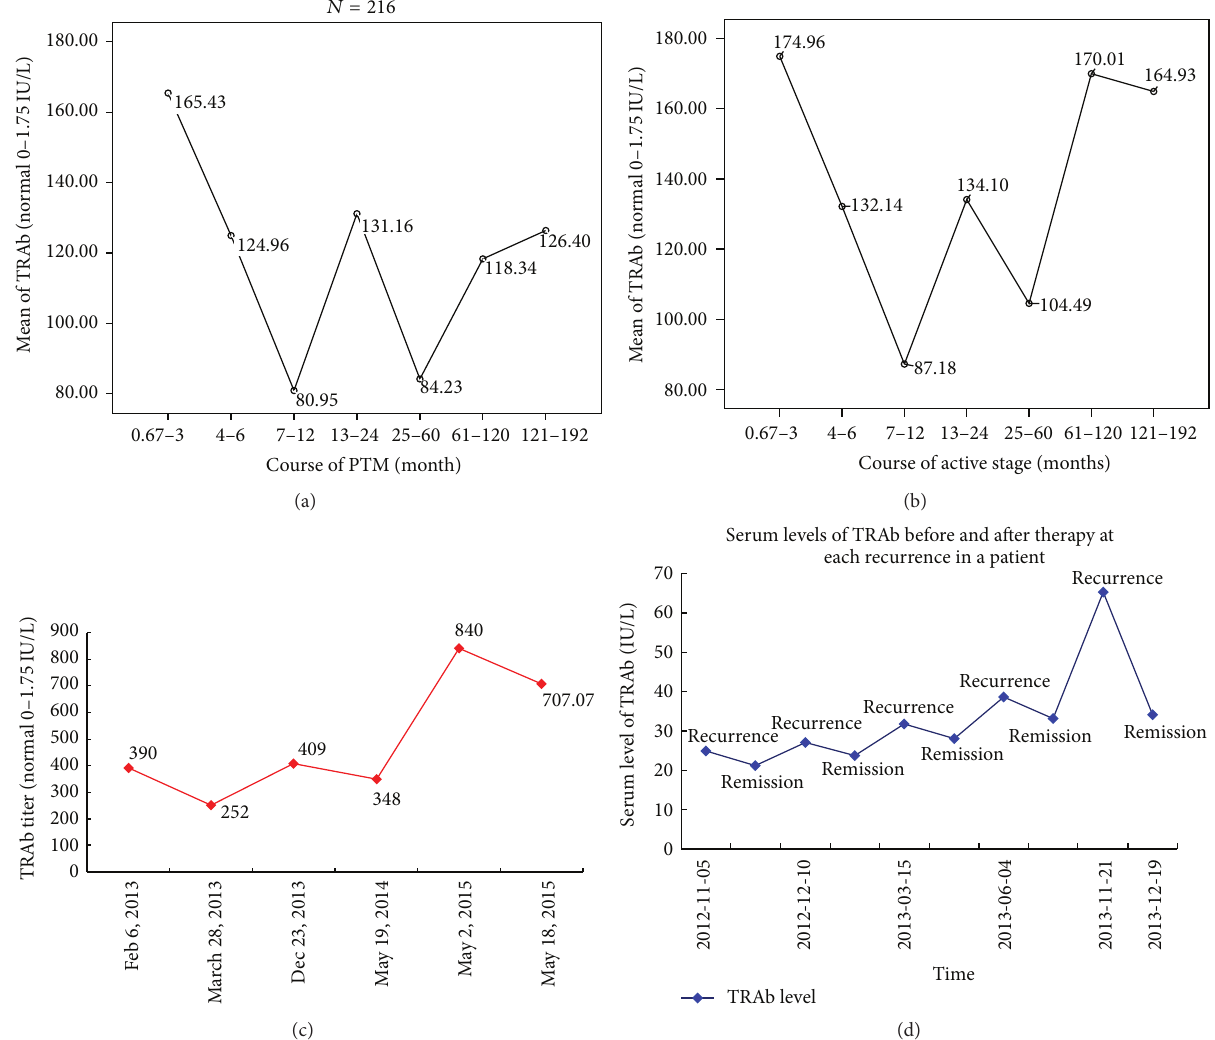
(c) Figure 14: The fluctuation of serum TRAb levels with the extension of course. (a) Means of serum TRAb titers fluctuated with the extension of course in 216 PTM cases. The serum TRAb titers were 165.43 ± 187.162 IU/L ( 𝑁 = 33 ) between 20 days and 3 months of course, 124.96 ± 105.861 IU/L ( 𝑁 = 30 ) between 4 and 6 months, 80.95 ± 76.816 IU/L ( 𝑁 = 52 ) between 7 and 12 months, 131.16 ± 161.686 IU/L ( 𝑁 = 43 ) between 13 and 24 months, 84.23 ± 96.621 IU/L ( 𝑁 = 27 ) between 25 and 60 months, 118.34 ± 231.437 IU/L ( 𝑁 = 27 ) between 61 and 120 months, and 126.40±153.059 IU/L ( 𝑁 = 4 ) between 121 and 192 months. By multiple comparisons with Post Hoc Tests, the serum TRAb titers between 0.67 and 3 months were statistically higher than those between 7 and 12 months ( 𝑝 = 0.011 ) and those between 25 and 60 months ( 𝑝 = 0.035 ), respectively. Mean difference and 95% confidence intervals were 84.48 [ 19.74, 149.22 ] and 81.2 [ 5.71, 156.69 ] , respectively. There were no significant differences among 0.67–3, 4–6, 13–24, 61–120, and 121–192 months of PTM course ( 𝑝 > 0.05 ). The data demonstrated that the serum TRAb levels fluctuated in the 16-year course. (b) In 185 cases at active stage, means of serum TRAb titers fluctuated with the extension of a 192-month course. (c) In a PTM case with repeats of remission and relapse in about 2 years after a 14-year history, serum TRAb titers fluctuated between 252 IU/L and 840 IU/L. Even though his course was more than 14 years and steroid therapy, there were no trends of autoimmunity activity to stop and of PTM lesions to subside spontaneously. (d) In a patient with 5 repeats of recurrence and remission from November 5, 2012, to December 19, 2013, serum TRAb titers increased when lesion recurred and decreased when lesions subsided after